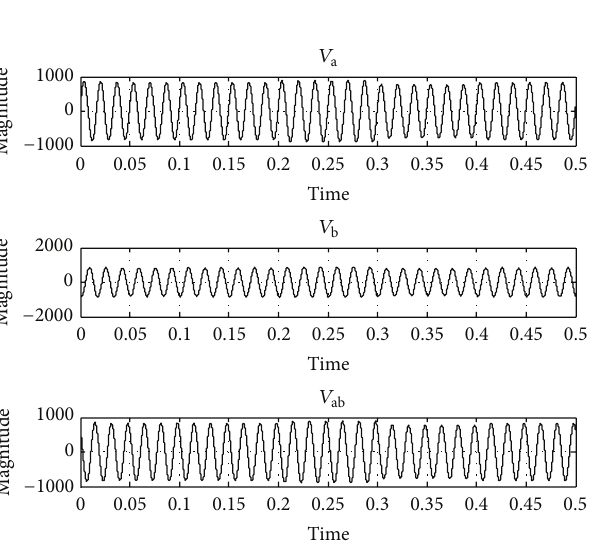
Figure 6: The proposed flow diagram for the ACO-FL control technique.